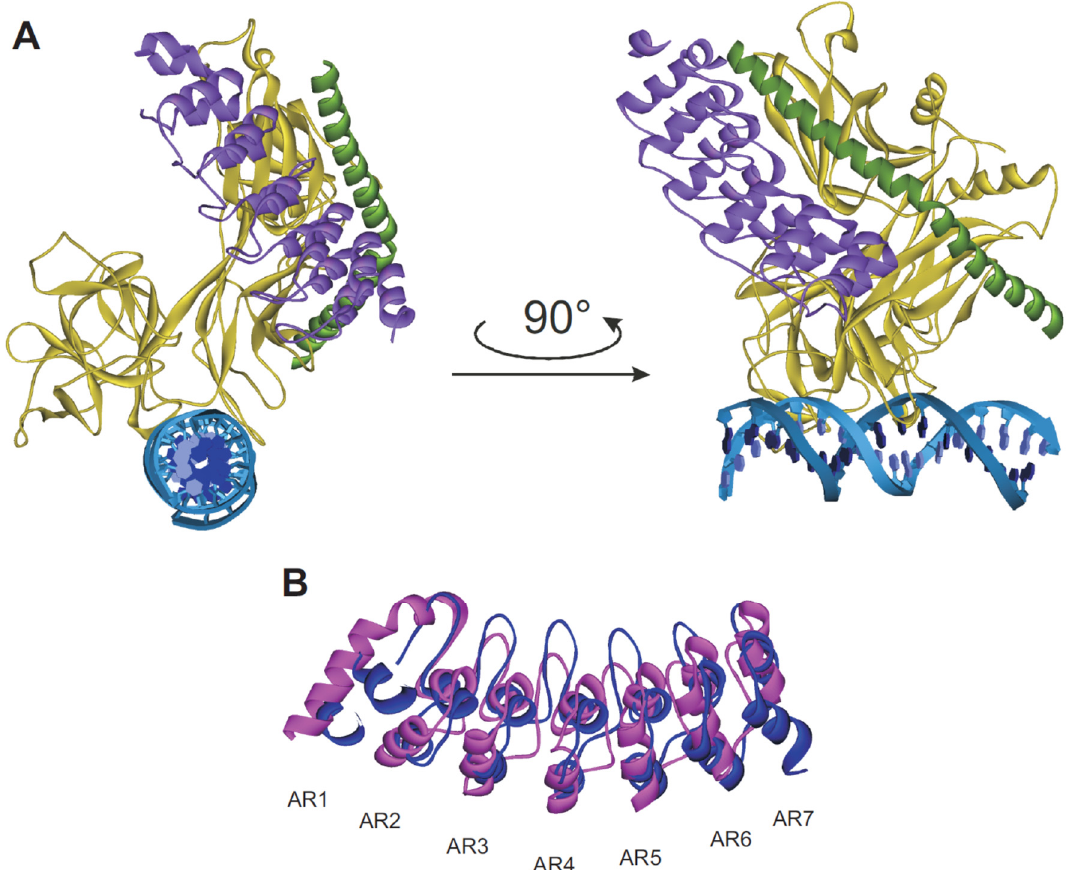
Figure 3. Proposed functional model of Nank. ( A ) Overall structure of the MAML-1:ANK:CSL:DNA complex (PDB ID: 2F8X) in ribbon representation. The ankyrin domain is purple colored, the MAML-1 polypeptide is colored as dark green and the RHR-N, β -trefoil, and RHR-C domains of CSL are colored gold. The two DNA strands are colored blue and cyan [84]. ( B ) Superposition of Nank showing the conformational changes induced in the AR1 upon complex formation. Free Nank is depicted in magenta (PDB ID: 1OT8) [82] and Nank in the complexed state in blue (PDB ID: 2F8X) [84] .